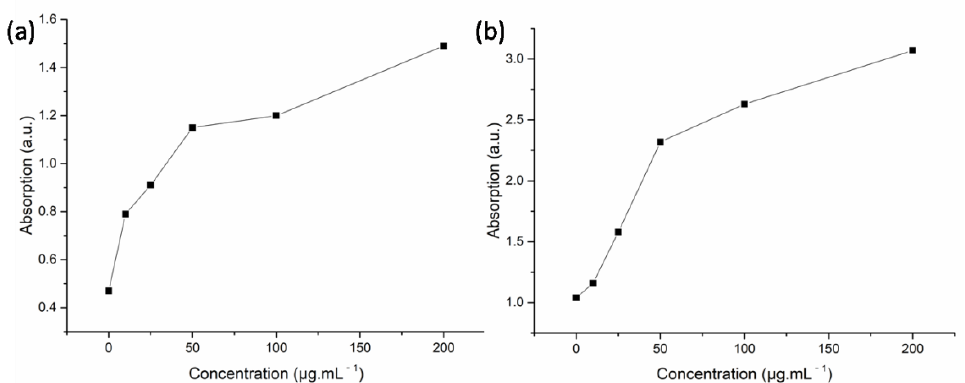
Figure 6. Leakage of DNA ( a ) and protein ( b ) of silver nanoparticles against V. mali . 3.4.4. Synergistic Antimicrobial Effect of Silver Nanoparticles Conjugated with Iprodione